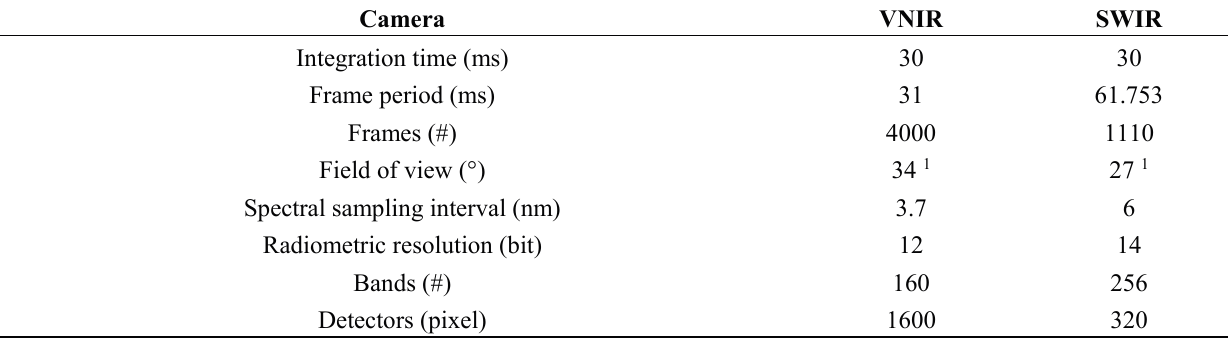
Figure 3. Experimental setup. The two HySpex cameras are located ca . 10 m in front of the outcrop. The measurement mode consisted of a clockwise rotation. Table 1. Campaign settings for the two HySpex cameras. A high integration time was used because direct illumination was not present and due to the low reflectance